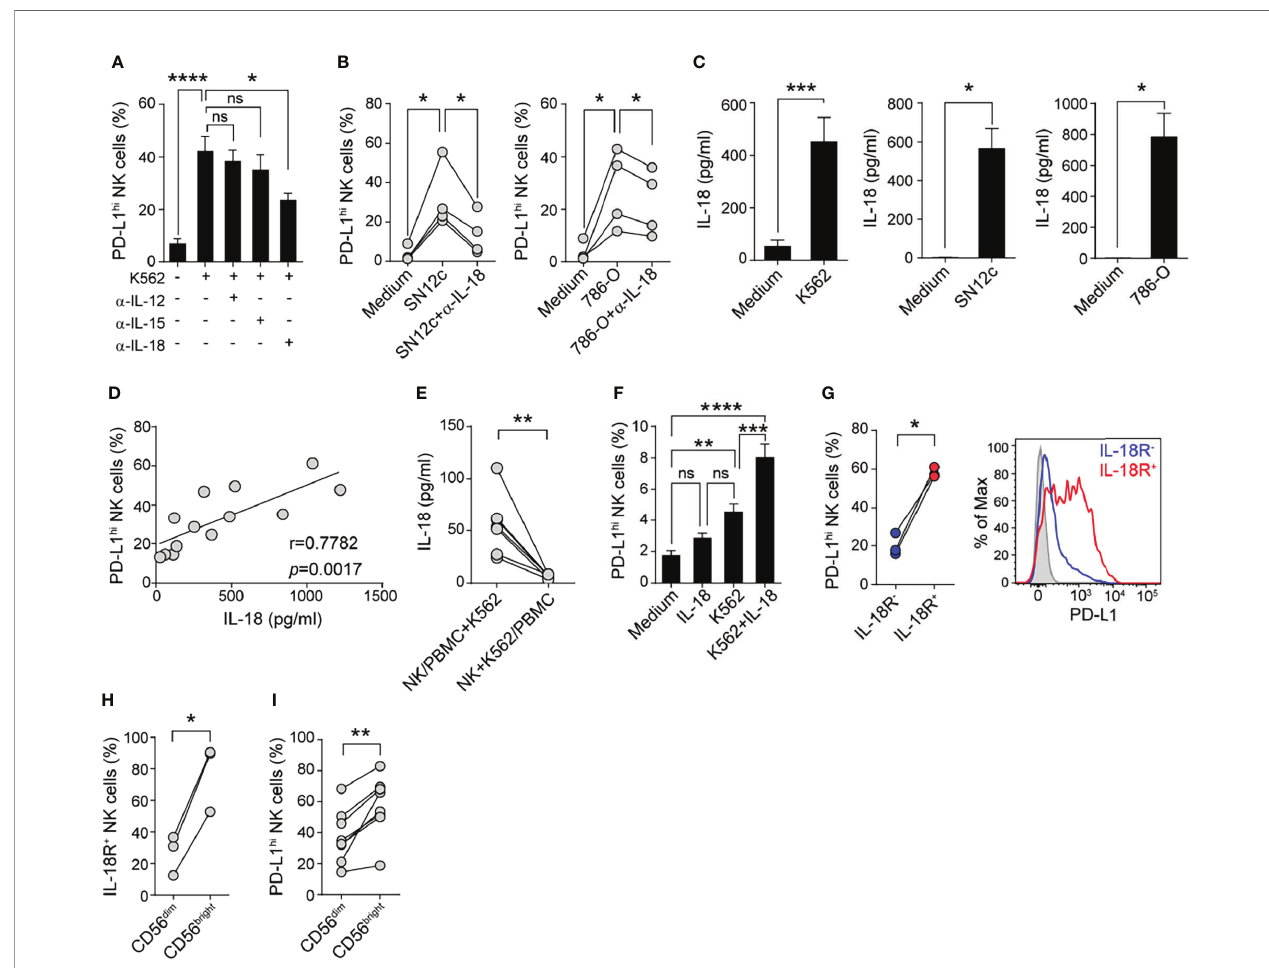
FIGURE 4 | IL-18 produced during tumor-stimulation of PBMC enhances PD-L1 expression on tumor-experienced NK cells. (A) Frequency of PD-L1 hi NK cells after culture of PBMC in the absence (Medium) or in the presence of K562 cells and different cytokine-neutralizing mAb for 48 h, assessed by fl ow cytometry (n=5). (B) Frequency of PD-L1 hi NK cells after culture of PBMC in the absence (Medium) or in the presence of SN12c cells (left) or 786-O cells (right) and in the absence or in the presence of an anti-IL-18-neutralizing mAb for 48 h, assessed by fl ow cytometry (n=4). (C) , IL-18 concentration in supernatants of PBMC cultured in the absence (Medium) or presence of K562 cells (n=13), SN12c cells (n=4) or 786-O cells (n=4), assessed by ELISA. (D) Correlation between the concentration of IL-18 detected in the culture supernatants of PBMC stimulated with K562 cells and the frequency of PD-L1 hi NK cells (n=13). (E) IL-18 concentration in supernatants of PBMC cultured in contact with K562 cells and separated from isolated NK cells by Tw (left) or PBMC separated from isolated NK cells and K562 cells by Tw (right), assessed by ELISA (n=7). (F) Frequency of PD-L1 hi NK cells after culture of isolated NK cells in the absence (Medium) or in the presence of IL-18, K562 cells or K562 cells and IL-18 (K562+IL-18) for 48 h, assessed by fl ow cytometry (n=10). (G) Frequency of PD-L1 hi cells detected in IL-18R a + (red) and IL-18R a - NK cells (blue) after stimulation of PBMC with K562 cells for 48 h, assessed by fl ow cytometry (n=3). A representative histogram is shown. (H) Frequency of IL-18R a + cells among CD56 dim and CD56 bright NK cells after culture of PBMC in the presence of K562 cells for 48 h (n=3). (I) Frequency of PD-L1 hi cells among CD56 dim and CD56 bright NK cells after culture of PBMC in the presence of K562 cells for 48 h (n=8). Data represent mean ± SEM. One-way ANOVA with Dunnett´s (A, B) and Tukey´s (F) post hoc test, two-sided Student´s t test (C, E, G – I) and Pearson´s correlation (D) . ns, non-signi fi cant; * p <0.05, ** p <0.01, *** p <0.001, **** p